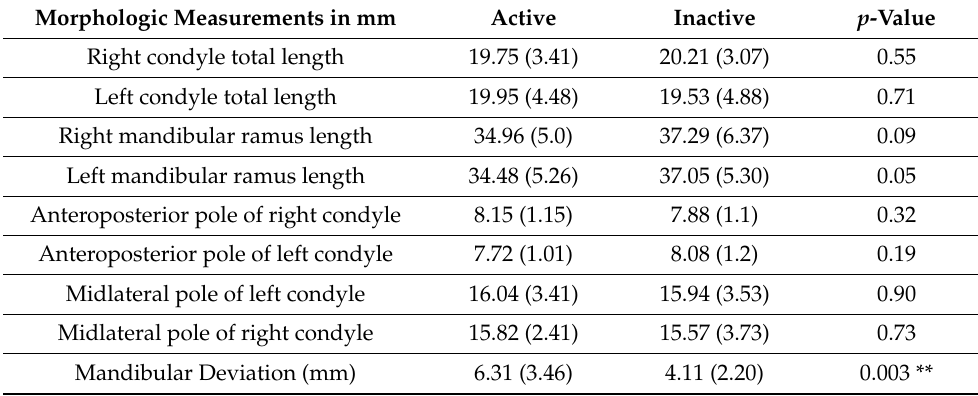
Table 4. Comparison of morphologic measurements in active/inactive unilateral condylar hyperpla- sia (UCH) cases.